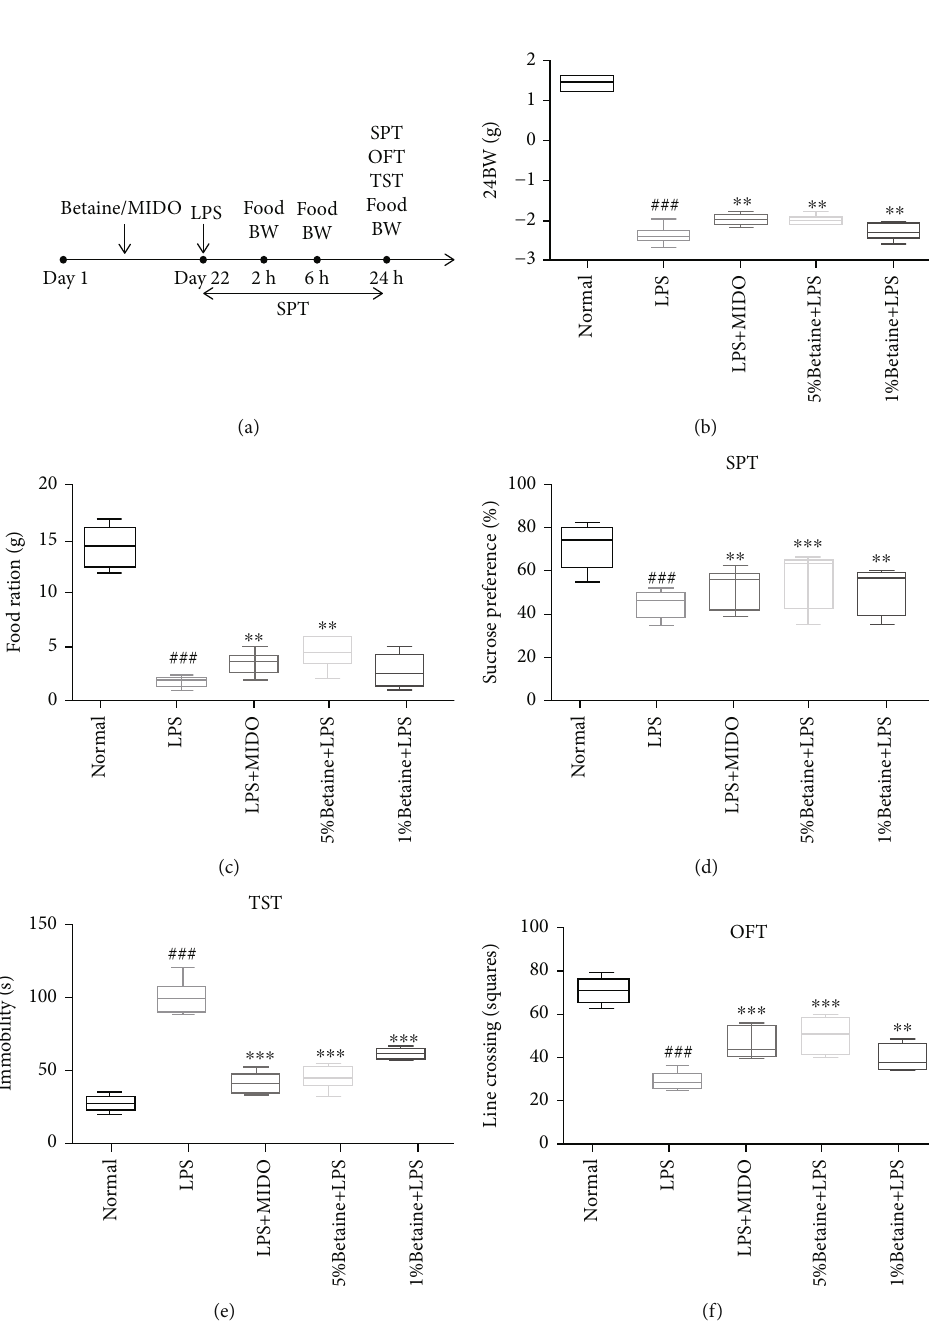
Figure 2: E ff ects of betaine on food intake, body weight, and depressive behavior in LPS-induced depression-like mice. (a) Experimental fl ow chart. (b) Changes in body weight of mice, 24 hours after LPS injection. (c) Changes in food intake in mice, 24 hours after LPS injection. (d) In fl uence of betaine on sucrose preference test. (e) In fl uence of betaine on tail suspension test. (f) In fl uence of betaine on open fi eld test. The results were expressed as median ± interquartilerange ; ### P < 0 : 01 compared to the normal control group; ∗∗ P < 0 : 01 and ∗∗∗ P < 0 : 001 compared to the model group, n = 12